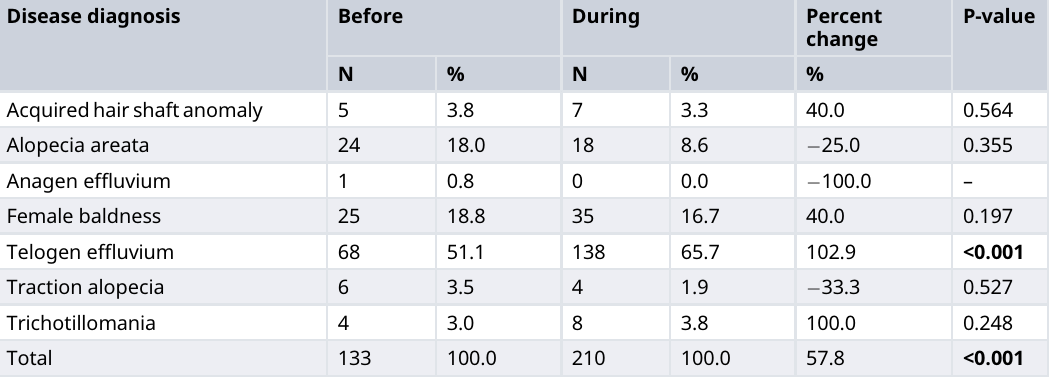
Table 6. Types of hair fall before and during the coronavirus disease 2019 (COVID-19) pandemic. Disease diagnosis